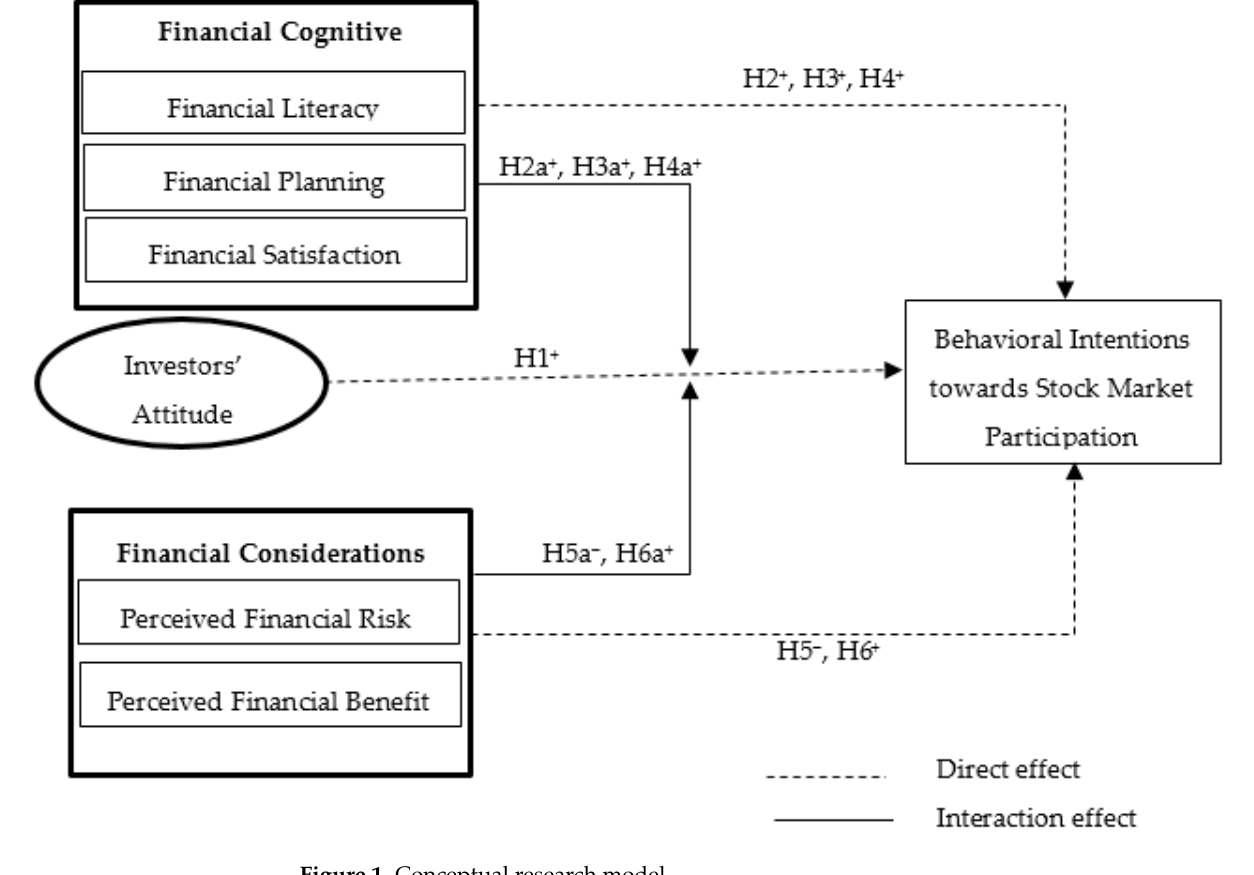
Figure 1. Conceptual research model.